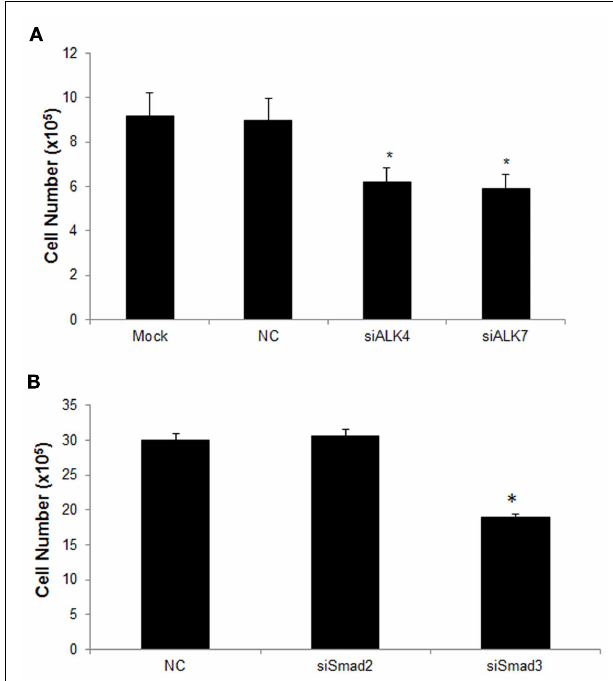
FIGURE 4 |TheALK4/ALK7–Smad3 pathway is involved in Nodal induced U87 cell growth. (A) U87-Nodal cells were transiently transfected with siRNAs targeting ALK4 (siALK4) or ALK7 (siALK7), scrambled negative control (NC), or without siRNAs (mock transfection). Cell growth was determined using direct cell counting at 48h after transfection. Data are mean ± SEM ( n = 6). * P < 0.05 v. smock and NC group. (B) U87-Nodal cells were transiently transfected with siRNAs targeting Smad2 or Smad3, or NC, cell number was counted at 48h after transfection. SiRNA targeting Smad3, but not Smad2, significantly reduced the cell growth. * P < 0.05 vs. control. Data are mean ± SEM ( n = 4). Results shown are representatives of three independent